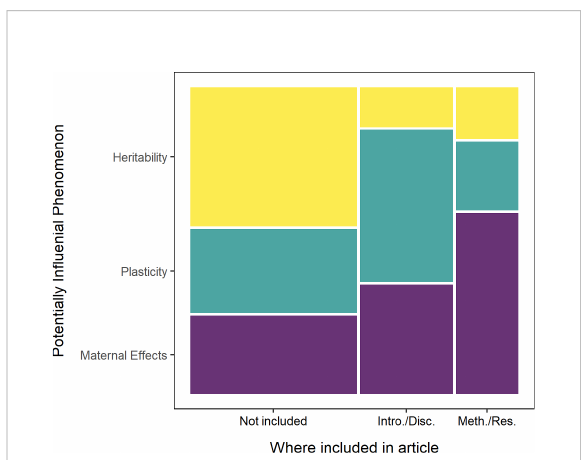
(Introduction or Discussion) or included (Methods or Results) the potentially in fl uential phenomena of trait heritability, plasticity, and maternal effects. Approximately half of studies did not include any discussion of these phenomena (51%), almost a third addressed their role in the broader context of their study (29%), and only a fi fth explicitly included them in their methodology and data analysis (20%). Of the three, the topic of plasticity was most frequently included in the ‘ Introduction or Discussion ’ (50%), followed by maternal effects (35%), and heritability (15%). The top two topics switch for inclusion in the ‘ Methods or